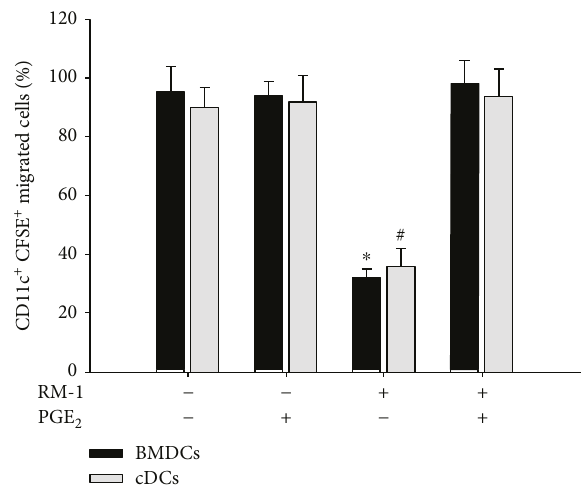
Figure 4: PGE promotes DCs homing in vivo. DCs were activated 2 by LPS in the presence or absence of conditioned medium from the RM-1 as well as PGE and stained with CFSE. The 2 percentage of CFSE-positive DCs migrating to the draining inguinal lymph nodes collected from mice injected with DCs was assessed by fl ow cytometry. Data were presented as the mean ± SD ( ∗ ,# P < 0 05 ). BMDCs: bone marrow-derived DCs; cDCs: spleen conventional